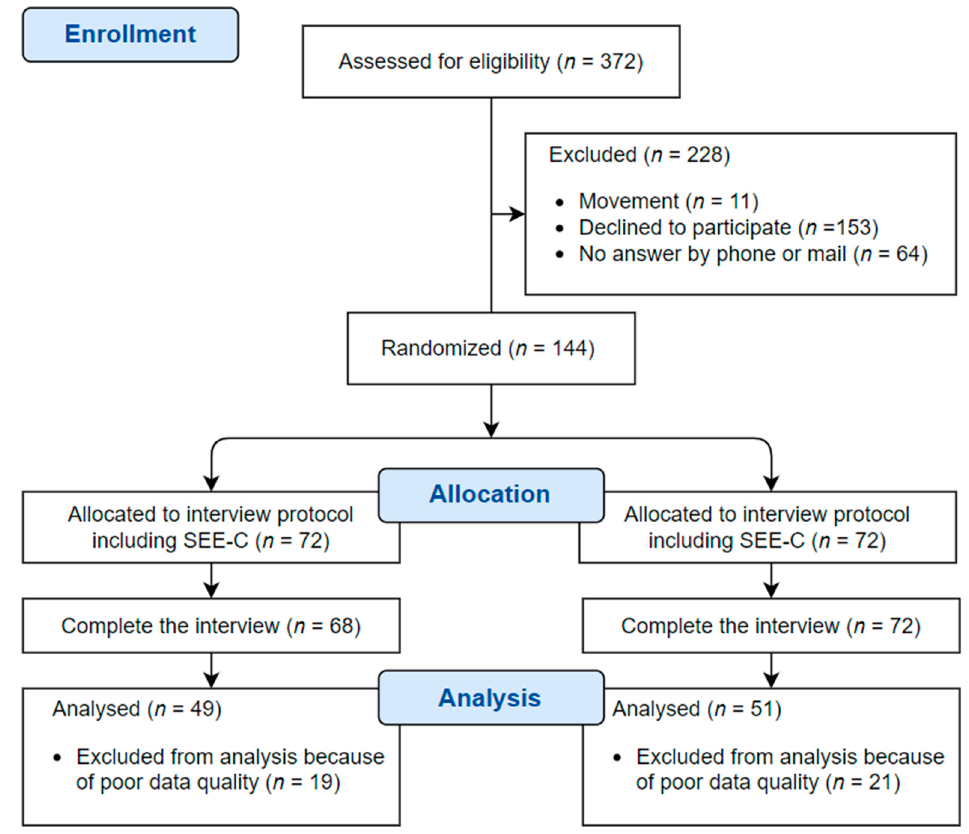
Figure 1. CONSORT Flow Diagram.